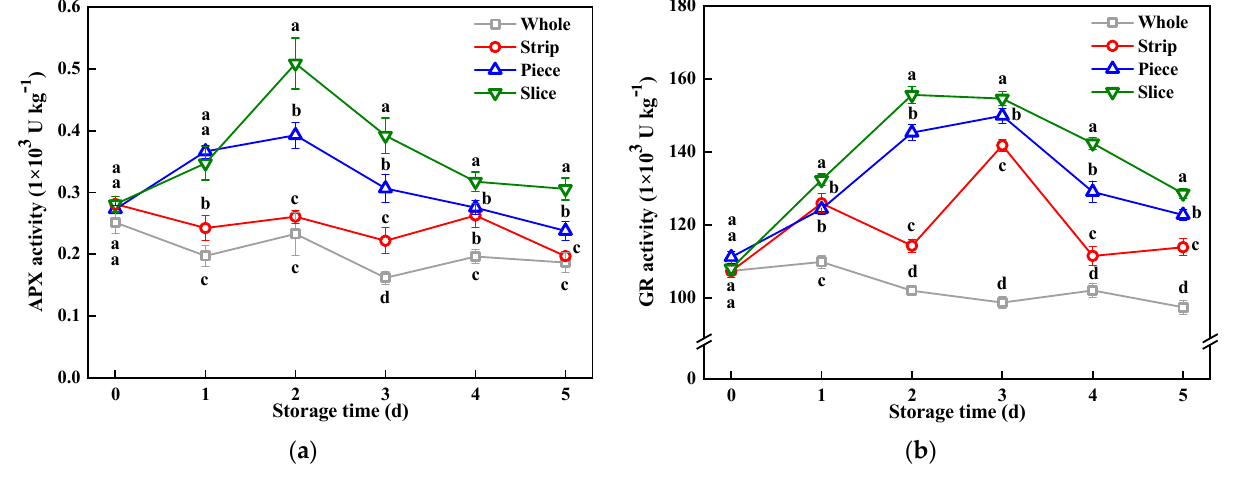
Figure 4. Effect of cutting methods on ascorbate peroxidase (APX) ( a ) and glutathione reductase (GR) ( b ) activity of fresh − cut cucumbers. Vertical bars represent the standard deviation of the mean (n = 3). Different letters indicate significant differences between the groups ( p < 0.05).